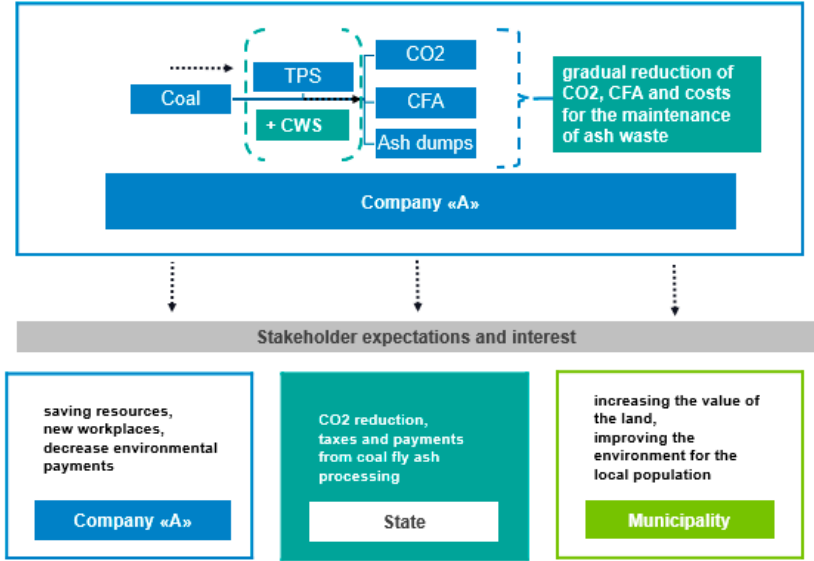
Figure 3. Recycling scenario within the scope of the CFA production company. Source: designed by authors.